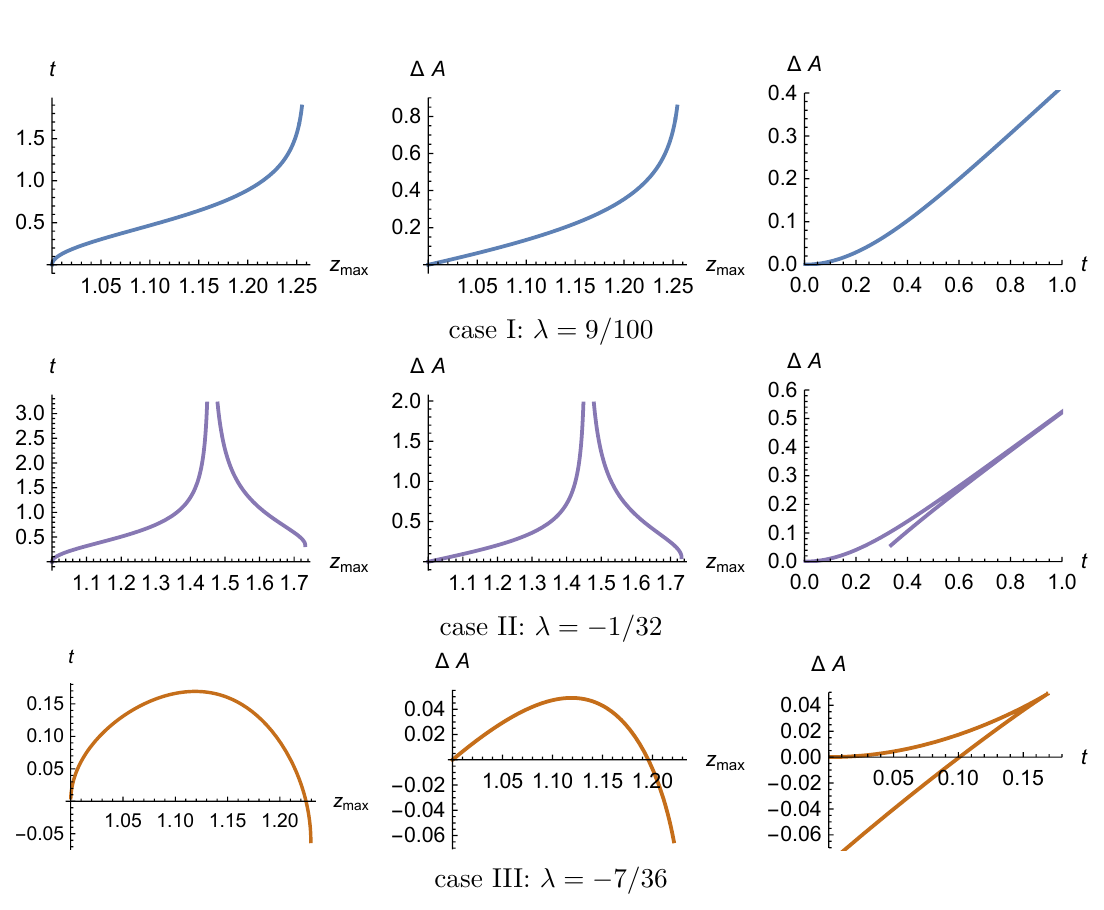
Figure 14 . Area and boundary time for extremal surfaces passing through the horizon for various couplings with d = 4